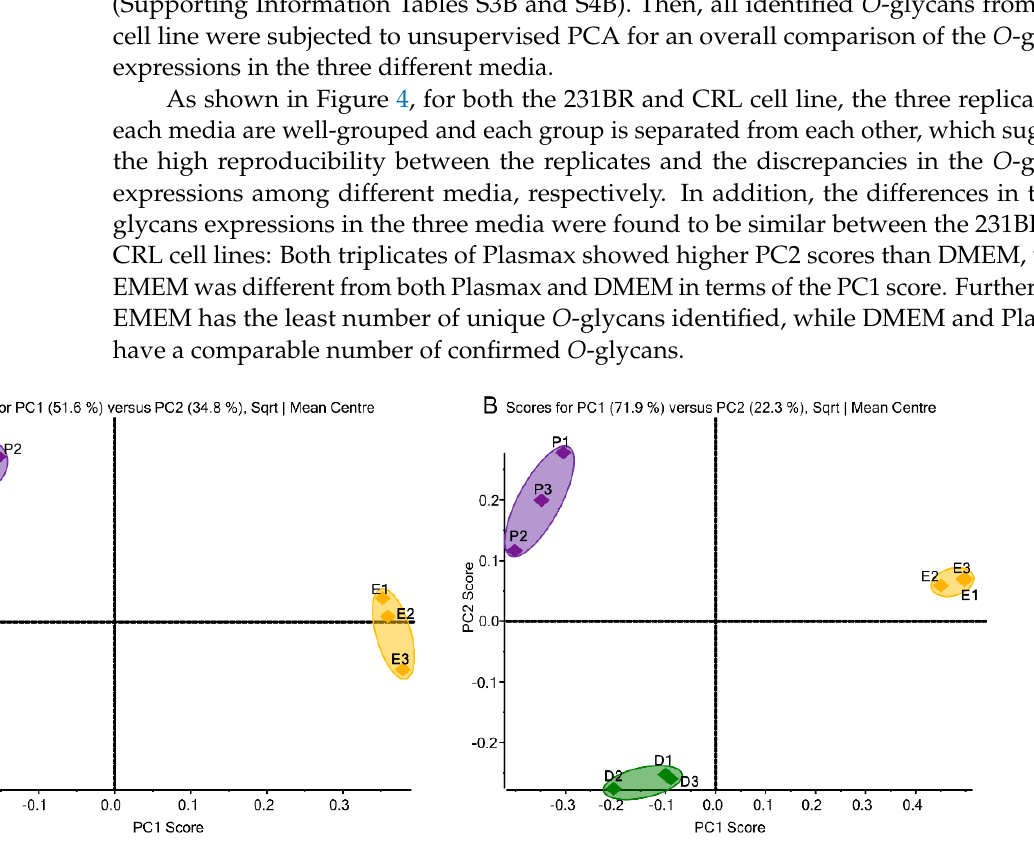
10 of 19 Table 1. Expression discrepancies of different types of N -glycans derived from 231BR and CRL cell lines in three media. The numbers in brackets are standard deviations (n = 3). p -values were calcu- lated using Student’s t -tests to indicate the significant level of differences. Expression Discrepancies of Different Types of N -Glycans Derived from MDA-MB-231BR Cell Line Glycan Type Plasmax-DMEM